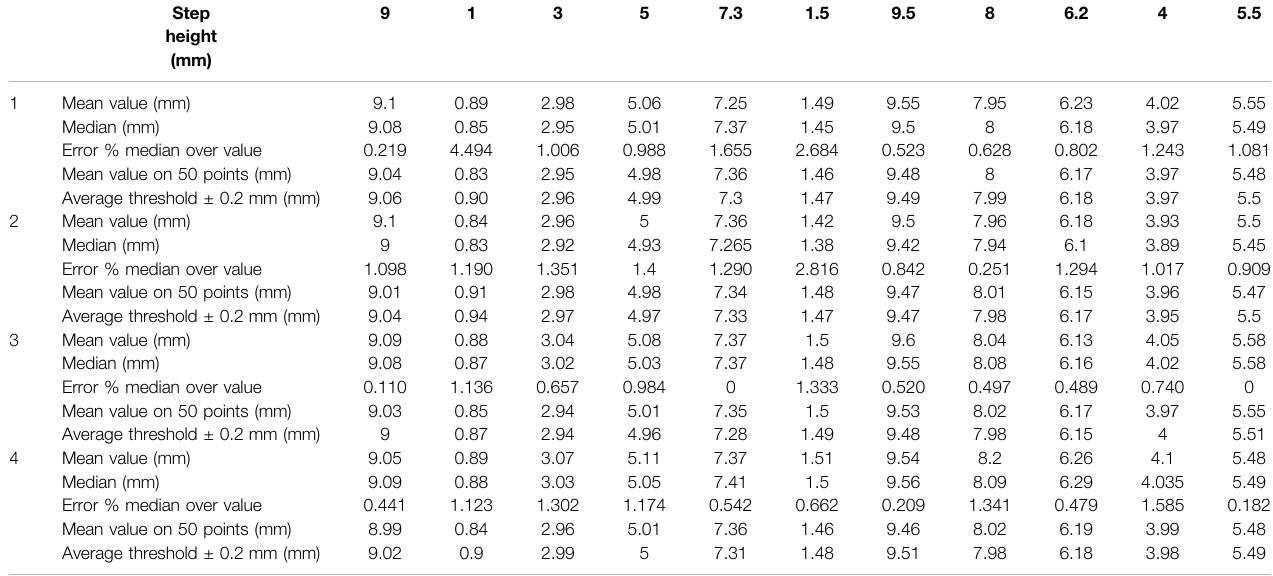
TABLE 4 | Average statistical parameters evaluated for the LPG-D sensitivity test; ad-hoc step height evaluation using the RS1 scanner with and without adapter. Average statistical parameters evaluated for the LPG-D sensitivity test Step height (mm)